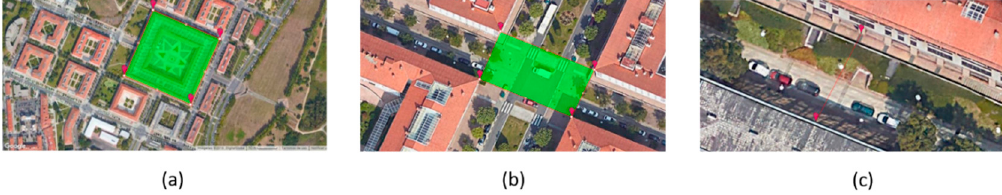
Figure 12. Manual reference. ( a ) Area of a building block. ( b ) Area of an intersection. ( c ) Width of a street.